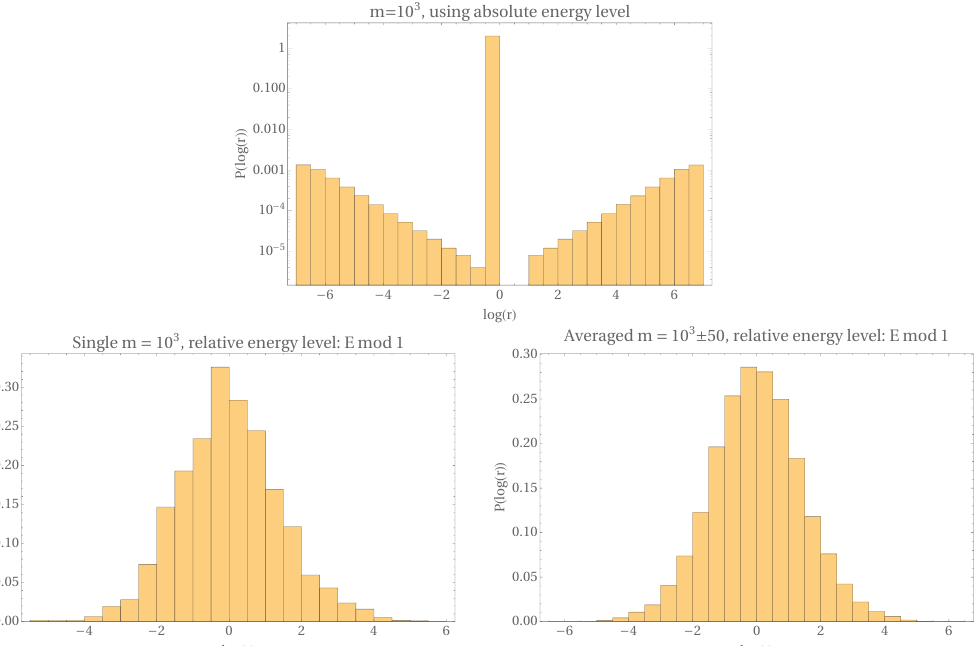
Figure 4 . Upper: level statistics of the absolute energy levels of the m = 10 3 minimal model. Lower left: level statistics of the m = 10 3 minimal model with energy levels taken modulo 1 and degeneracies ignored. Lower right: same as left graph but averaging minimal models between m = 10 3 (cid:0) 50 to m = 10 3 +